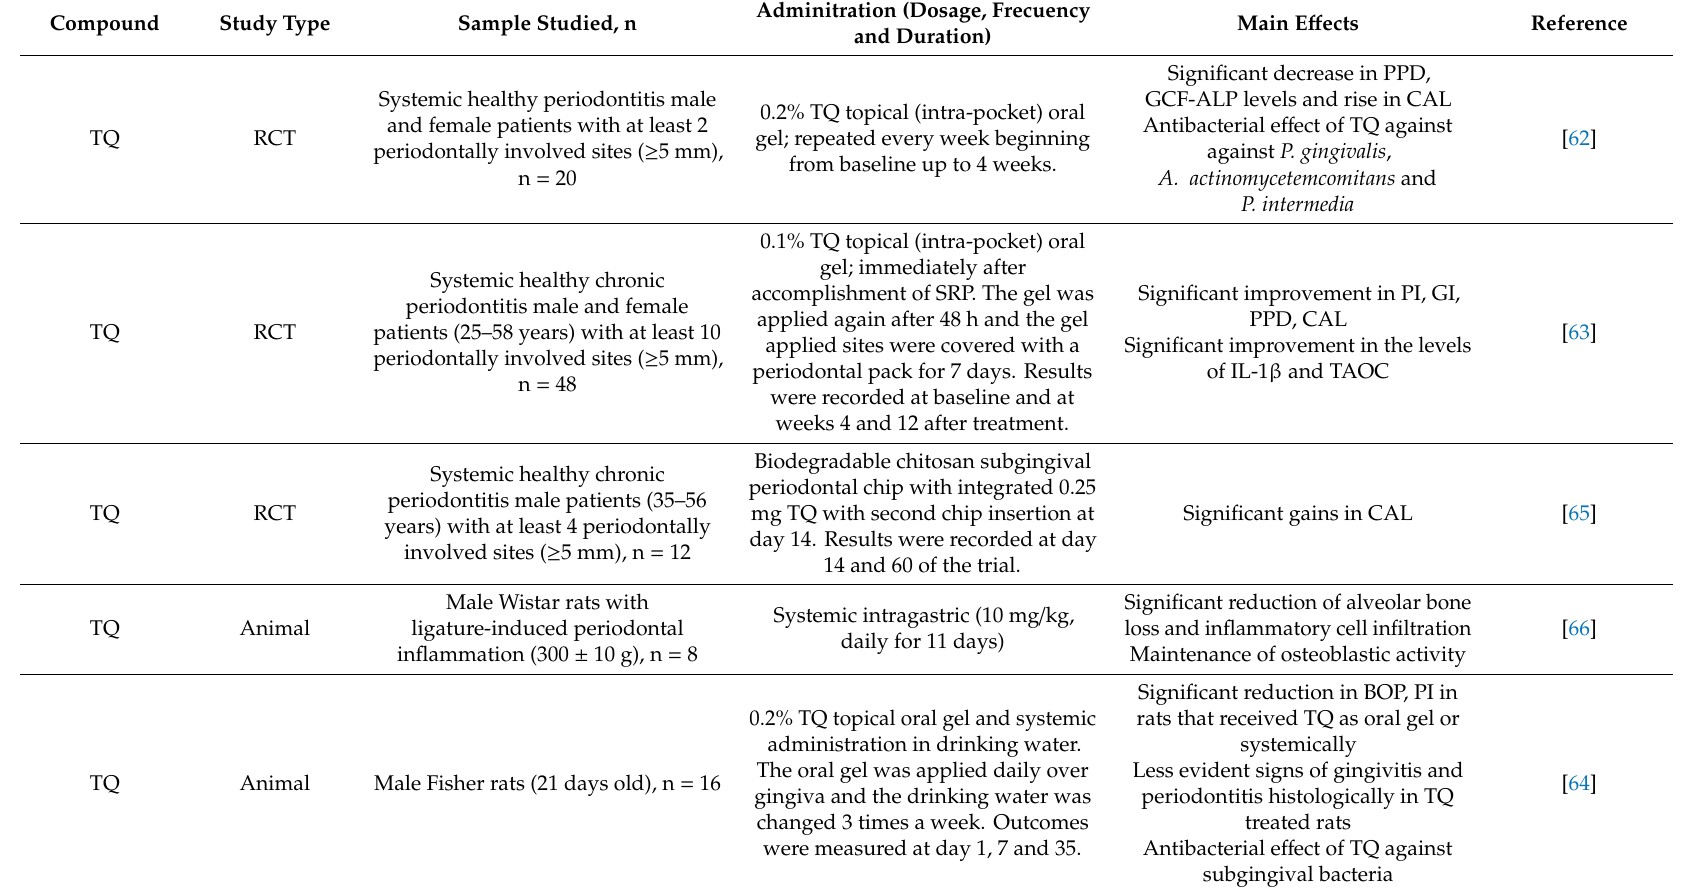
Table 3. Main studies in relation to thymoquinone (TQ) and Nigella sativa (NS) of interest in periodontal